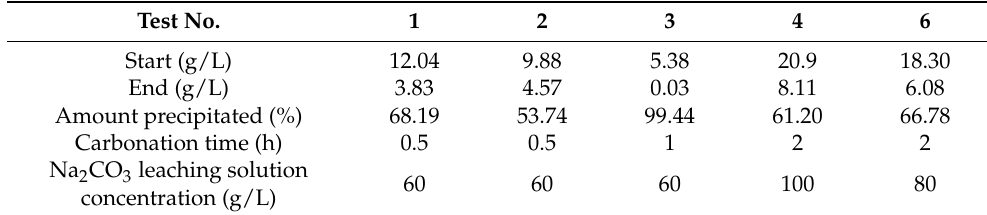
Table 12. Amounts of Al in solution at the start and end of precipitation tests. Test